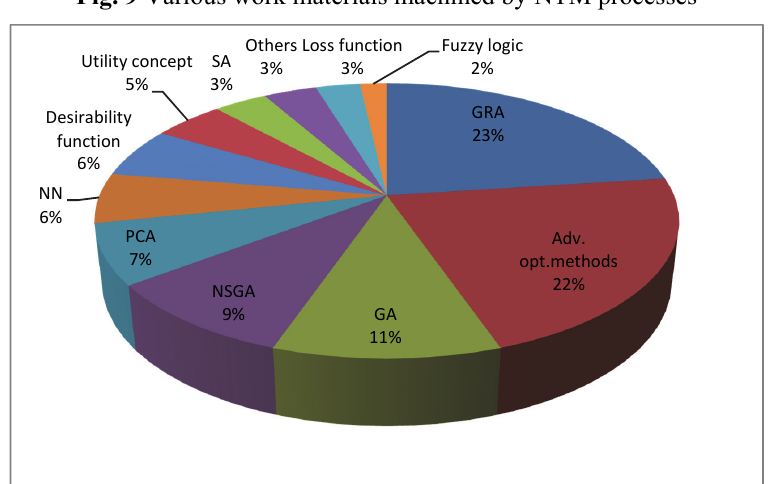
Fig. 9 Various work materials machined by NTM processes